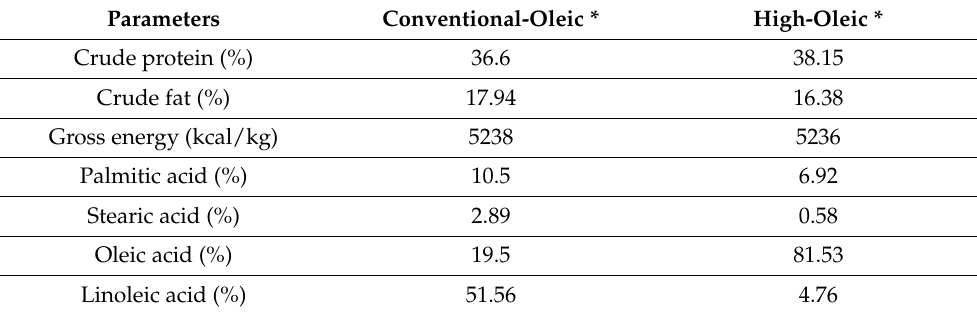
Table 1. Proximate Composition of Conventional and High-Oleic